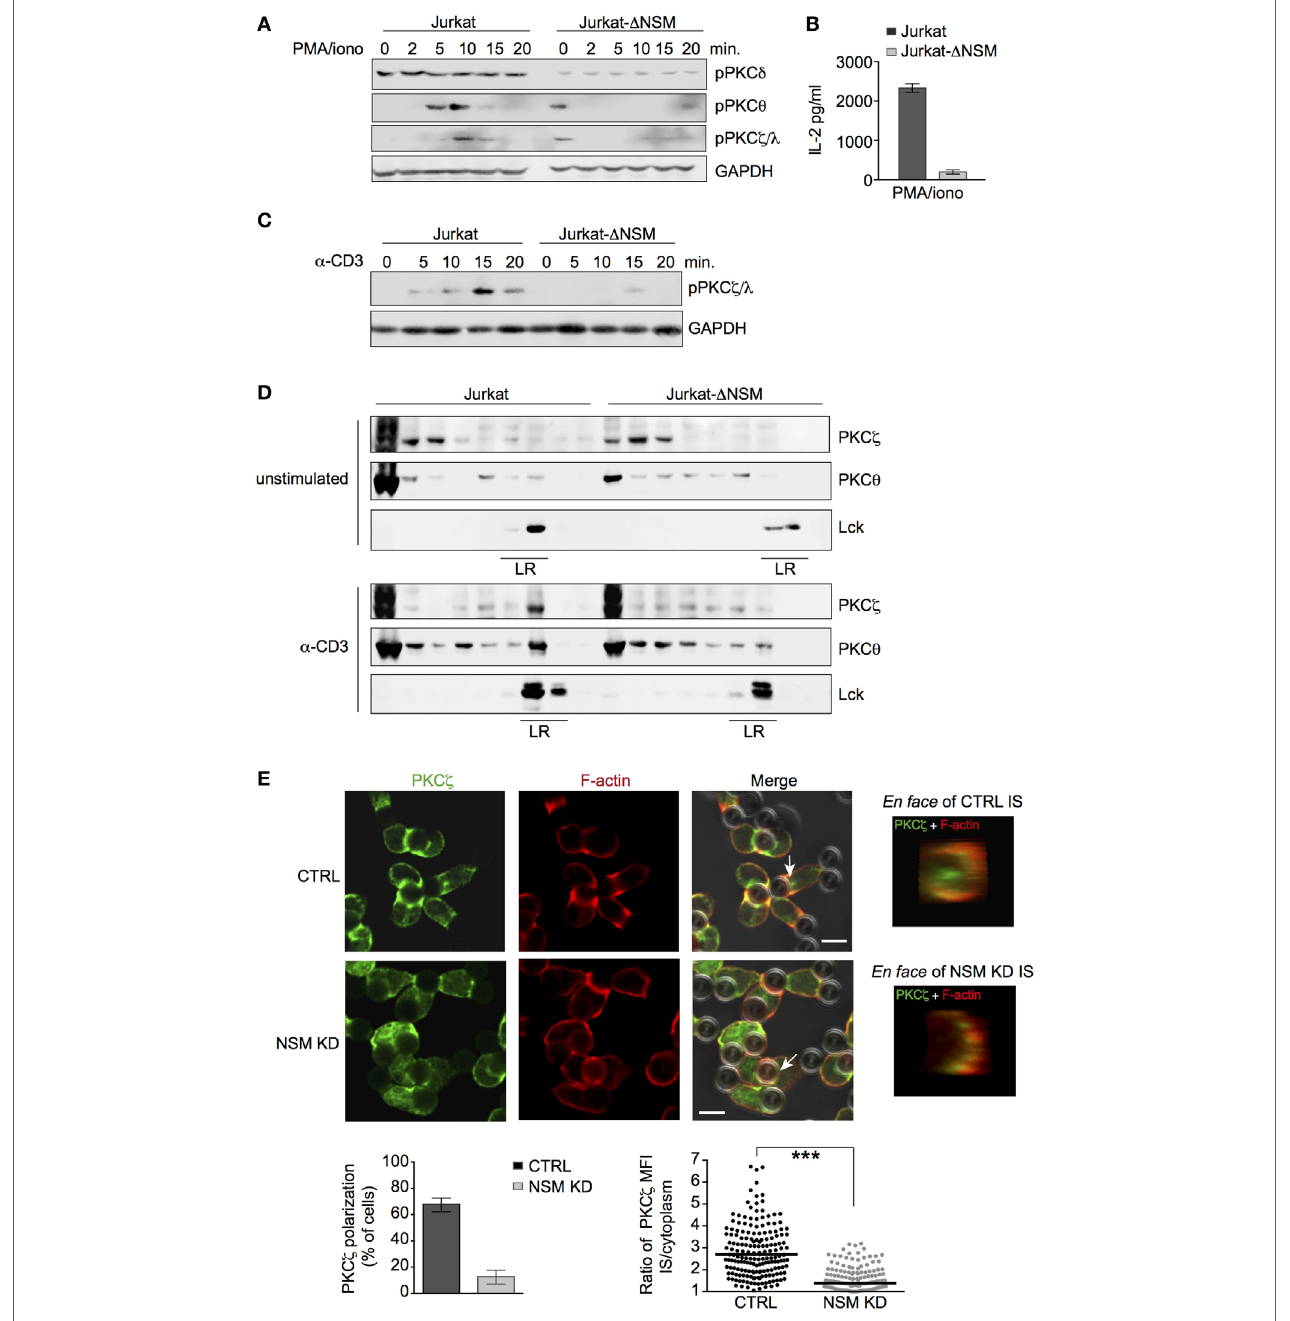
FigUre 5 | PKC ζ is an NSM downstream effector. (a,B) Jurkat- Δ NSM and control cells were stimulated with PMA/ionomycin. Accumulation of pPKC δ , pPKC θ , and pPKC ζ / λ was determined over time (a) and IL-2-release after 48 h (B) . (c) Accumulation of pPKC ζ / λ was determined in Jurkat- Δ NSM and control cells stimulated with α -CD3 over time. (D) Detergent resistant membrane (DRM) domain association of PKC ζ and PKC θ was determined in unstimulated (upper panels) and in 5 min α -CD3-stimulated (bottom panels) parental and Jurkat- Δ NSM cells (detection of Lck was used to identify DRM fractions). (e) PKC ζ and F-actin were co-detected in CTRL (IF panels, upper row) or NSM KD cells (IF panels, bottom row) 15 min after stimulation with α -CD3-coated beads. The percentage of cells polarizing PKC ζ (left graph) and relative polarization [immune synapse (IS)/cytoplasm] in individual cells were quantified (right graph). PKC ζ IS localization was visualized by en face view (representative examples are shown in IF pictures on the right side). Size bars: 5 µM.